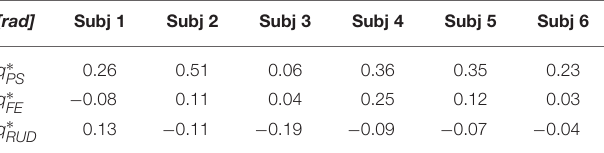
TABLE 2 | Subject-specific equilibrium postures ( q ∗ ) estimated via NIO from the average postural